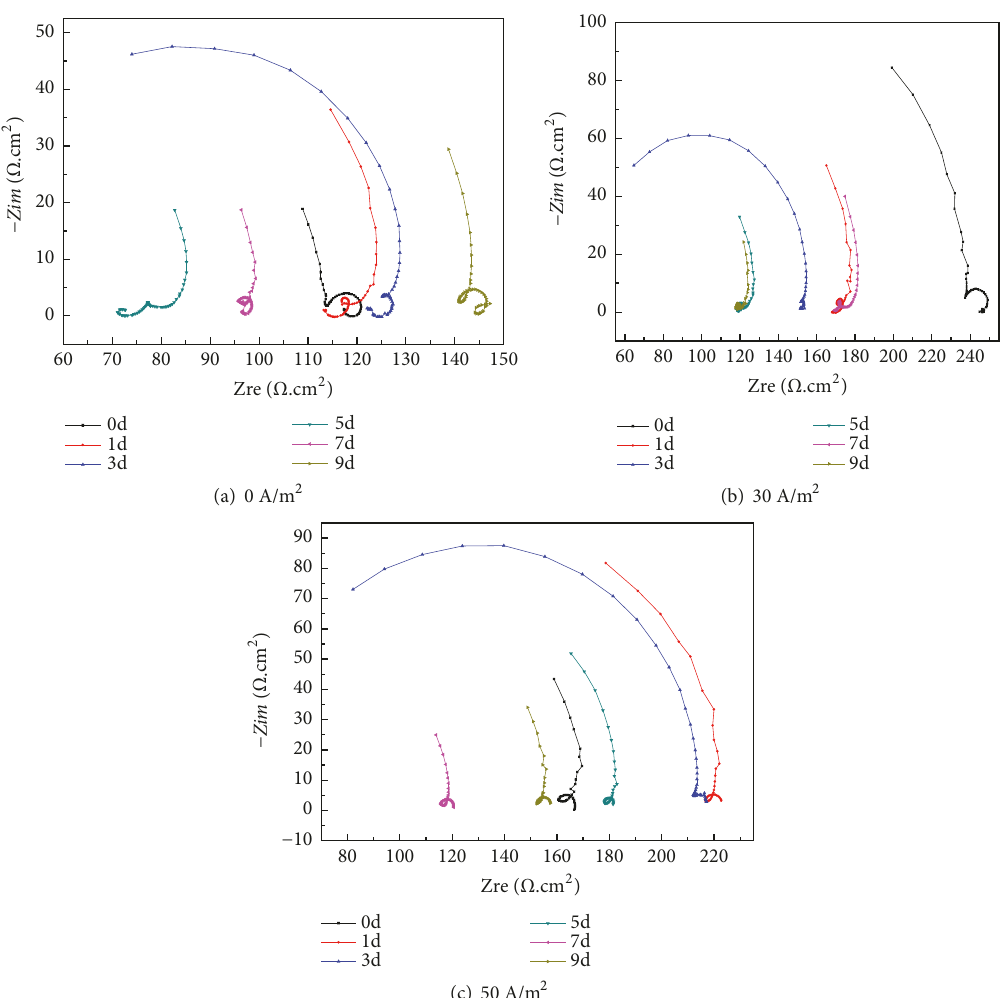
Figure 6: Electrochemical impedance spectroscopy under different AC current densities.